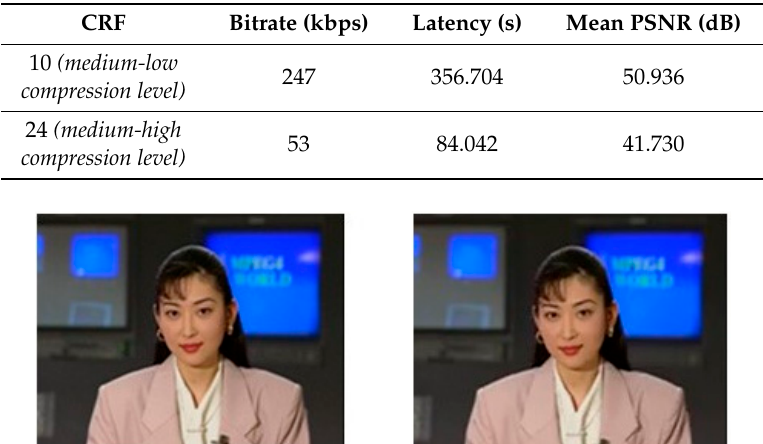
Table 2. Comparison of bitrate, latency (Latency, see Section 5.1) and PSNR (Peak Signal-to-Noise Ratio (PSNR), objective video (or signal) quality metric, analyzed in Section 5.6) according to CRF.